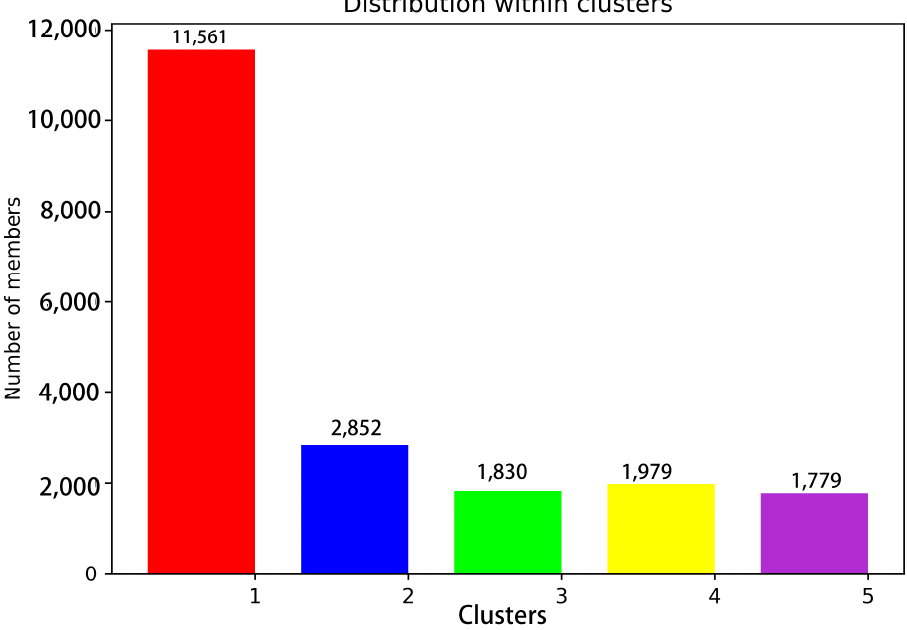
Figure 3. Statistics of 20,000 snapshot species per conformation cluster at 200 ns. Note: Red represents Cluster 1; blue represents Cluster 2; green represents Cluster 3; yellow represents Cluster 4; purple represents Cluster 5.